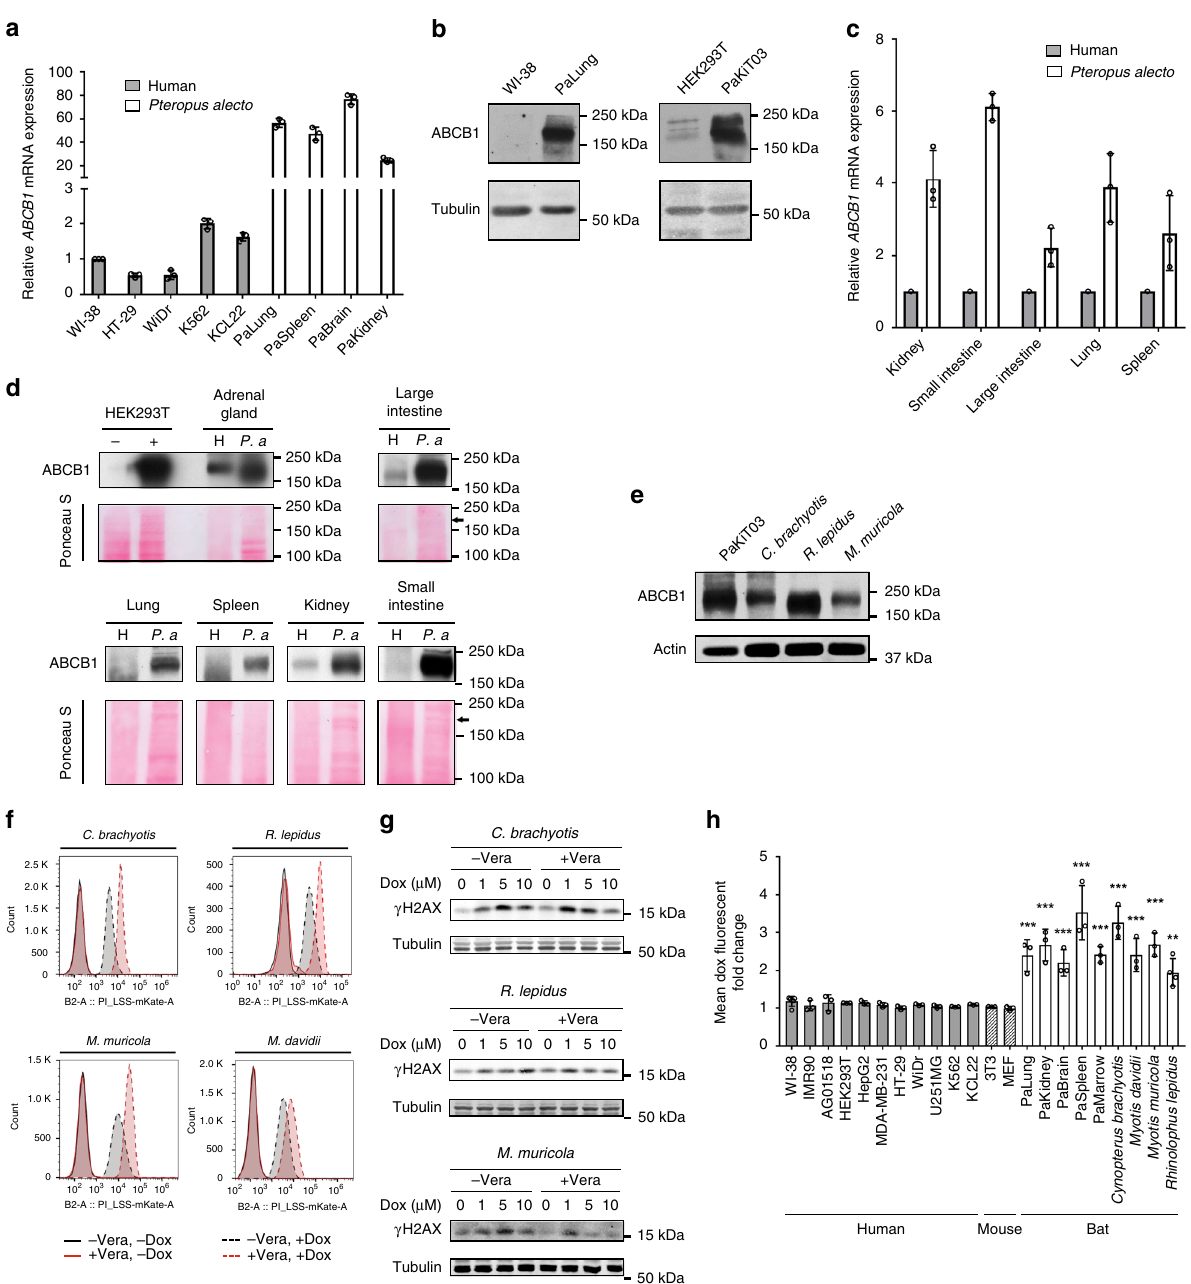
Fig. 7 ABCB1 expression and ef fl ux capability in human and multiple bat species. a qRT-PCR for ABCB1 mRNA expression in cell lines derived from human and P. alecto . ABCB1 mRNA expression is normalised to GAPDH and presented relative to the expression in WI-38 cells (mean ± SDs of three independent experiments). b Western blot analysis of ABCB1 in the indicated cell lines. Tubulin was used as a loading control. c qRT-PCR for ABCB1 mRNA expression in tissues derived from human ( N = 1) and P. alecto ( N = 3). ABCB1 mRNA expression is normalised to GAPDH and presented relative to the respective human tissues (mean ± SDs). d Western blot analysis of ABCB1 protein in the indicated tissues. Ponceau S staining of the membrane is shown as a loading control. Arrow indicates the size of ABCB1 protein. H and P. a indicate human and P. alecto respectively. Lysates from HEK293T transfected with control ( − ) or ABCB1 expressing plasmid ( + ) serve as negative and positive control, respectively. e Western blot analysis of ABCB1 in cells derived from the different bat species. Actin was used as a loading control. f Flow cytometry analysis of doxorubicin accumulation in cells derived from different bat species. Cells were treated and analysed as in Fig. 3b. g Western blot analyses of γ H2AX in cells derived from different bat species. Cells were treated as in Fig. 4. Blots are representative of three independent experiments. h Flow cytometry analysis of doxorubicin accumulation. Cells were pre-treated without or with 5 μ M verapamil (Vera) for 30 min before the treatment with 10 μ M doxorubicin alone or together with Vera for an additional 3 h. The fold change by Vera treatment is presented as the mean fl uorescence intensity of cells treated with both verapamil and doxorubicin relative to the mean fl uorescence intensity of cells treated with doxorubicin alone. Bars represent mean fold change ± SD of at least three experiments. Data shown in Figs. 3b, c and 7f are also included in this histogram. Statistical signi fi cances were calculated using unpaired student ’ s two-sided t test. ** p < 0.01, *** p <